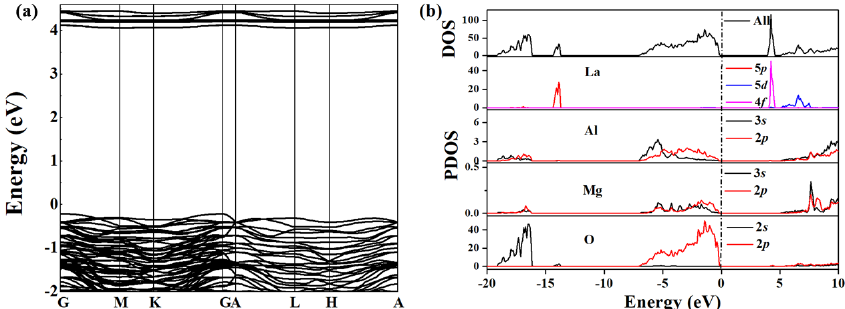
Figure 5. ( a ) Calculated energy band structure of LMA; ( b ) total and partial (La, Al, Mg, and O atoms) density of states (DOS) for LMA. PDOS—partial DOS.